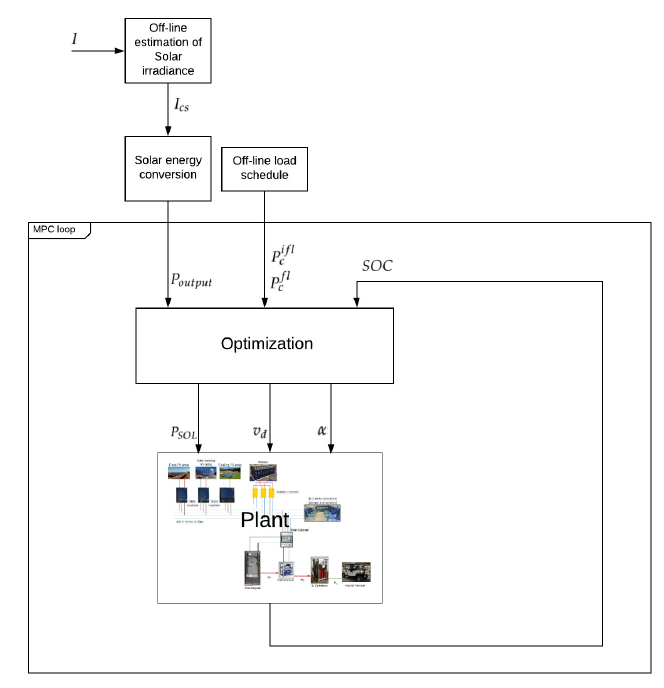
Figure 8. General control scheme of the proposed